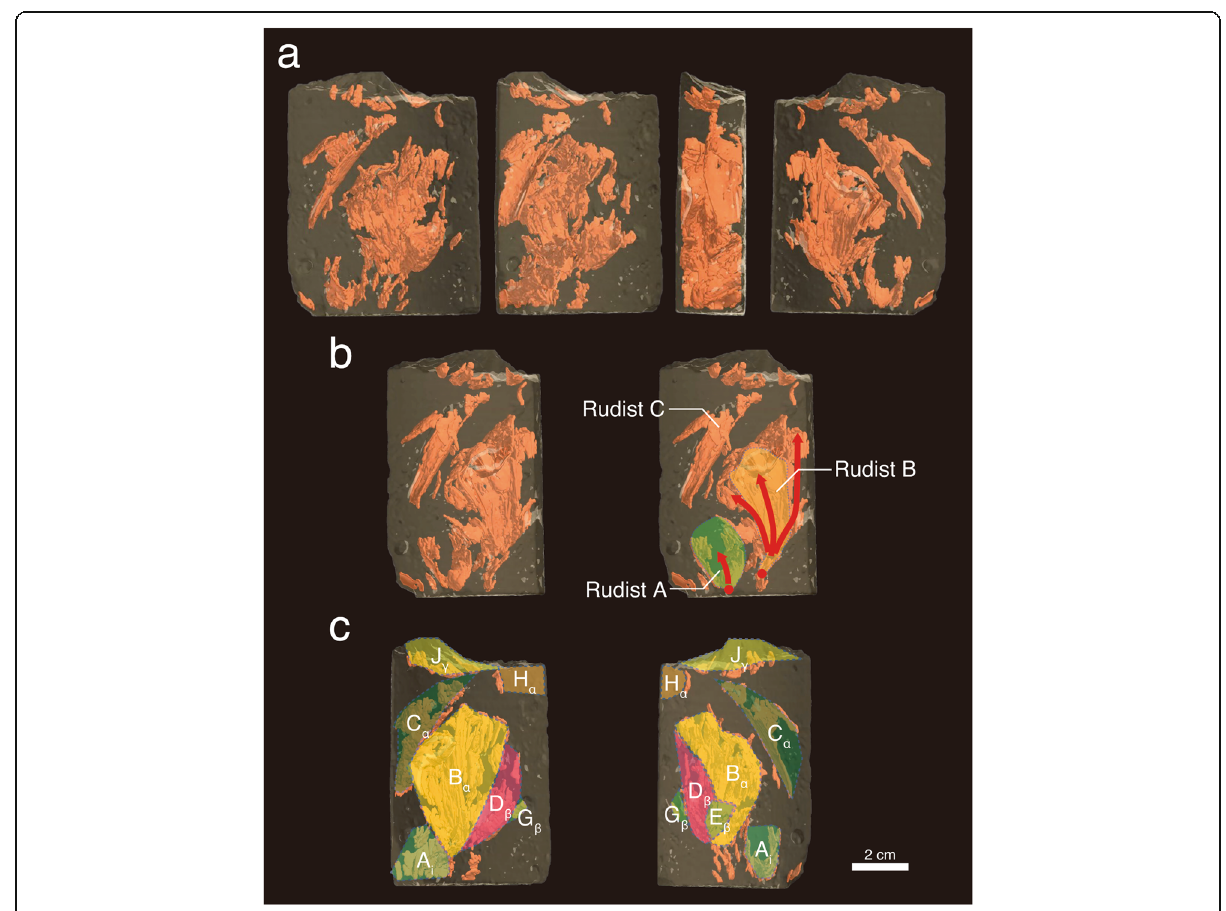
Fig. 5 X-ray CT images processed with a surface-rendering technique. a Surface-rendering-processed images of the studied core. The images are shown in clockwise rotation from the external core surface (left) to the split core surface (right). Orange color indicates rudists inside the core. b Surface-rendering-processed image (left) and its interpretation (right). Red lines and dots indicate the growth directions and spats from which the shell growth started, respectively. c Occurrences of rudists detected by the surface-rendering technique (left: external core surface, right: split core